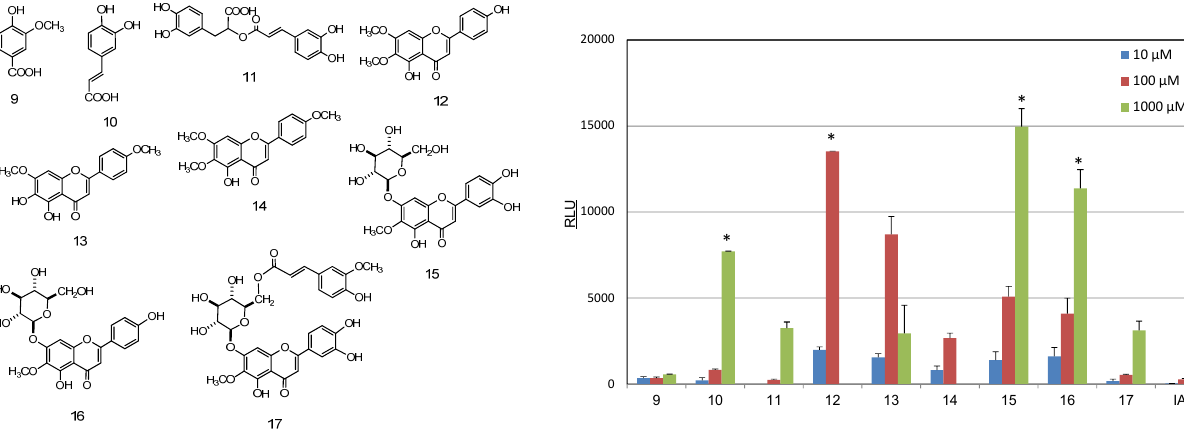
Figure 5. Induction of luciferase activity by compounds isolated from rosemary. The CALUX assay was used to measure luciferase activity. 9 . vanillic acid; 10 . caffeic acid; 11 . rosmarinic acid; 12 . cirsimaritin; 13 . ladanein; 14 . salvigenin, 15 : nepitrin, 16 . homoplantaginin; 17 . 6 ʺ - O -( E )-feruloylnepitrin; IAA. indole 3-acetic acid. * p < 0.05 vs.